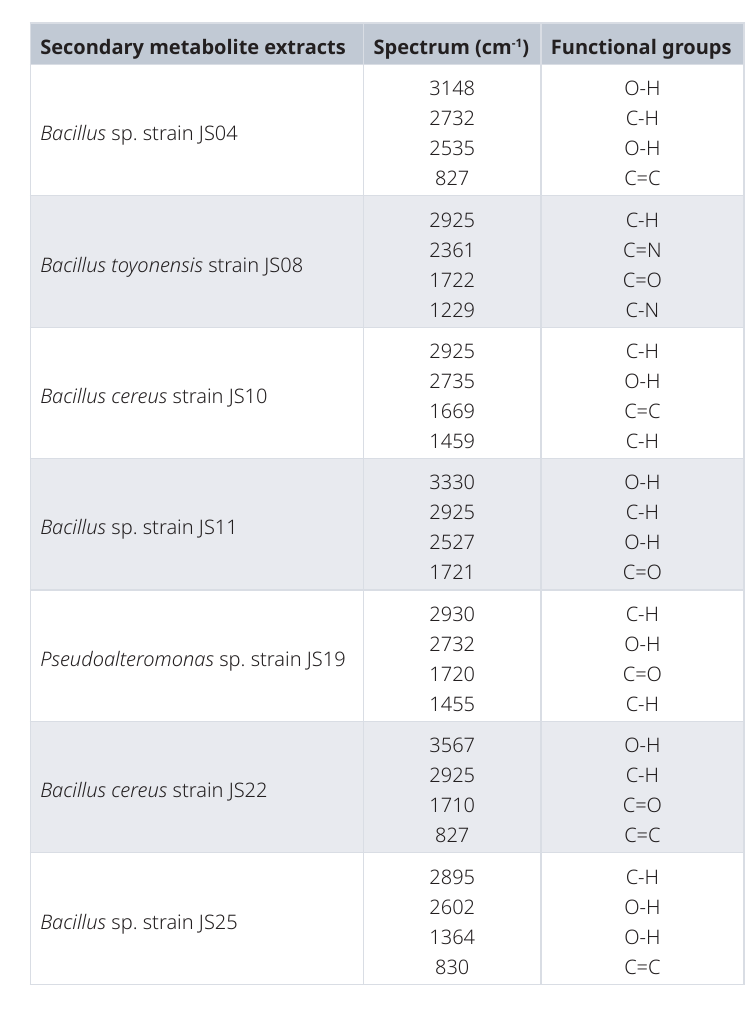
Table 1. Infrared spectrum of secondary metabolite extracts of heterotrophic bacteria.